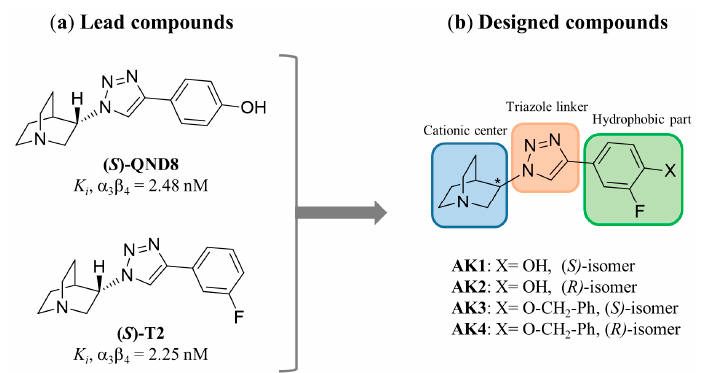
Figure 2. The design strategy of α 3 β 4 nAChR ligands. Table 1. In vitro binding affinity constants ( K i values) for binding of the quinuclidine-triazole deriv- atives towards human α 3 β 4 , α 4 β 2 , and α 7 nAChRs a .